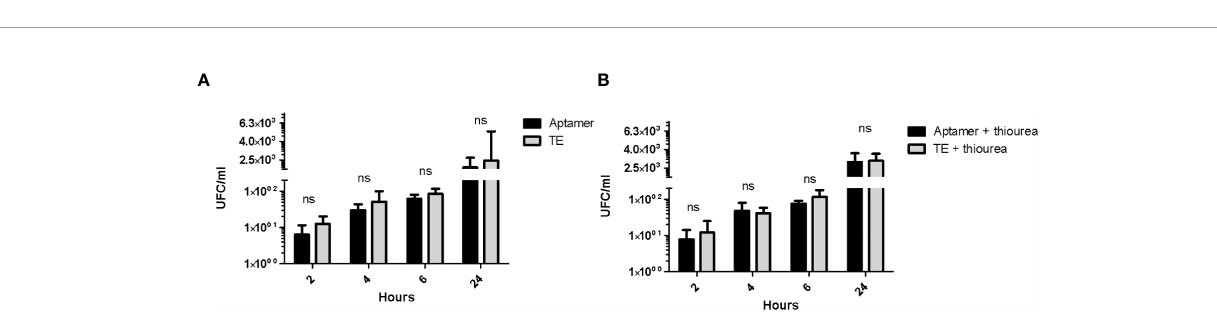
FIGURE 6 | Time-kill kinetics assay of A. baumannii with the A01 aptamer at 0.5µM (black) and TE buffer (grey) (A) without thiourea or (B) with thiourea added at 5µM. Non-parametric t test was applied for each time point, p = 0.25 for 2h; 0.88 for 4h; 0.88 for 6h and 0.66 for 24h. ns, non signi fi cant p